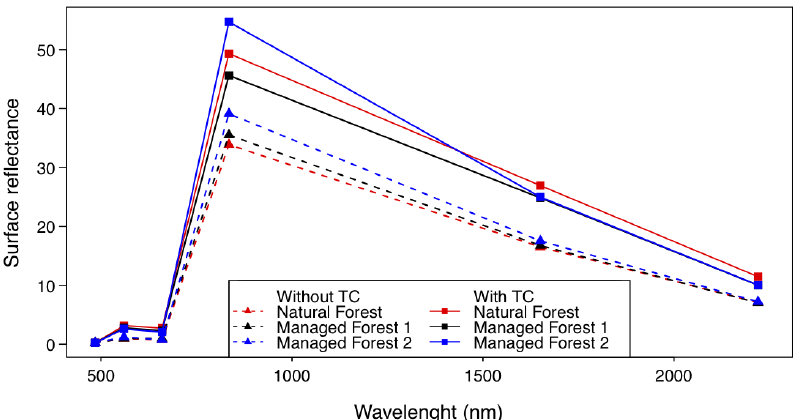
Figure 3. Landsat surface reflectance, without and with topographic correction for forest stand age classes.